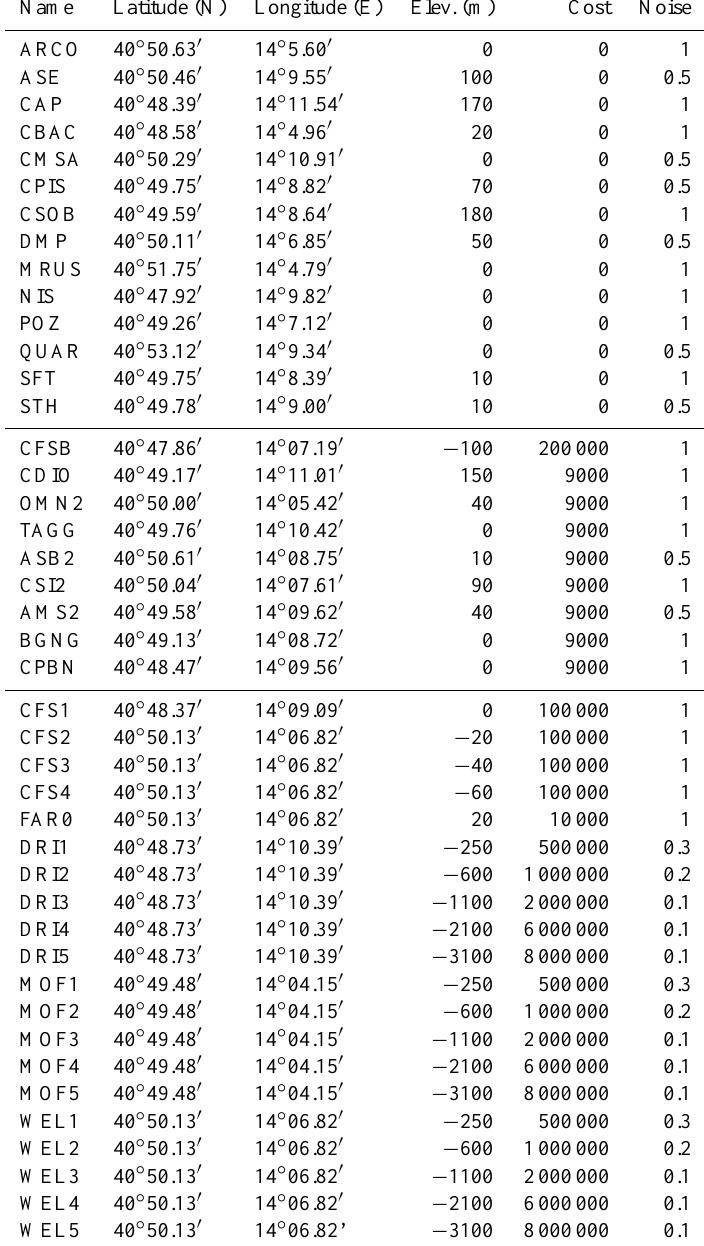
Table 1. Locations of the seismic stations used for the analysis. The right columns show an indicative installation cost (euro) and the mean seismic noise value around 10 Hz (µms − 1 ) used for the optimization analysis. The installation cost is an estimate performed taking into account the market values for the Campi Flegrei area. The first group of stations (top 14 rows) has been used for the sensitivity analysis. The second group represents the mobile seismic stations actually deployed in the Campi Flegrei area and the third group represents the other possible station positions. The second and third group positions are all used as possible location in the